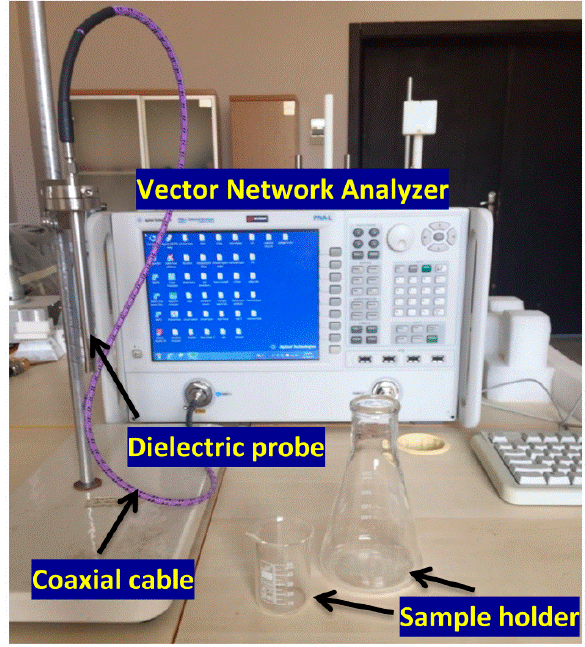
Figure 3. The experimental setup used in this work to measure the electrical properties of the samples.